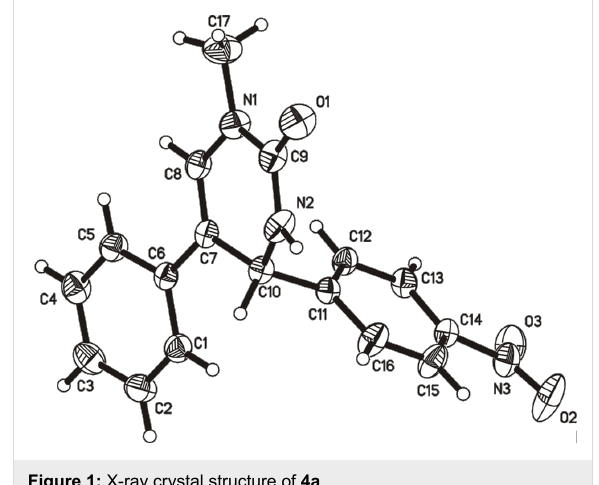
Figure 1: X-ray crystal structure of 4a